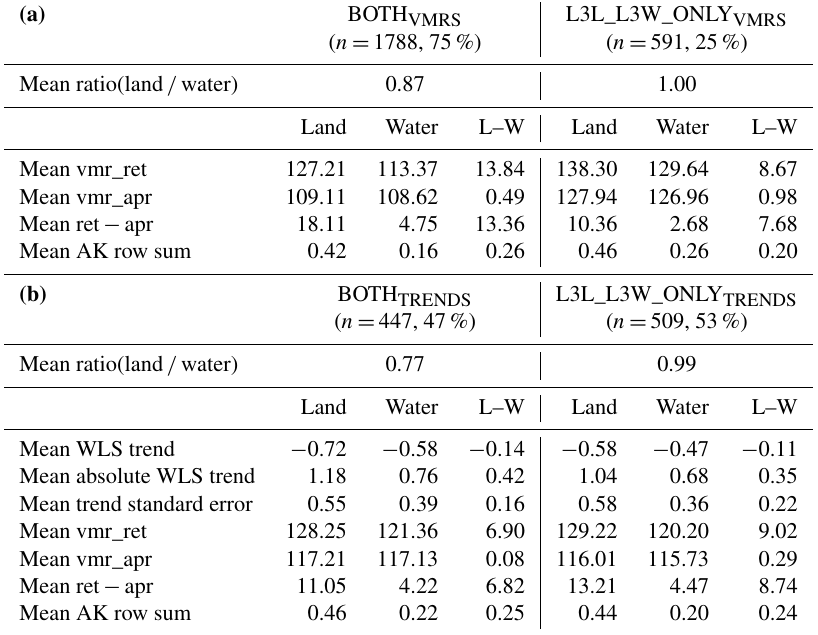
Table 4. (a) Descriptive stats corresponding to matched retrievals over land and water (L3L and L3W) where the long-term mean re- trieved surface level VMR in L3L and L3W is significantly different ( p < 0.1, n = 2379). Grid boxes are divided into two subsets depending on whether long-term mean VMRs in L3L and L3O M are significantly different ( p < 0.1; BOTH VMRs ) or not ( p > 0.1; L3L_L3W_ONLY VMRs ). The metric ratio(land / water) indicates the relative land vs. water surface coverage of an L3 grid box. A ra- tio(land / water) value > 1 ( < 1) implies that more of the grid box surface is covered by land (water). (b) Descriptive stats corresponding to matched retrievals over land and water (L3L and L3W) where the temporal trend detected using WLS regression analysis on yearly mean retrieved surface level VMR in L3L and L3W is significantly different ( p < 0.1, n = 956). Grid boxes are divided into two subsets depend- ing on whether the trend in L3L is significantly different to the corresponding trend detected in L3O M ( p < 0.1; BOTH TRENDS ) or not ( p > 0.1; L3L_L3W_ONLY TRENDS ). The metric ratio(land / water) indicates the relative land vs. water surface coverage of an L3 grid box. A ratio(land / water) value > 1 ( < 1) implies that more of the grid box surface is covered by land